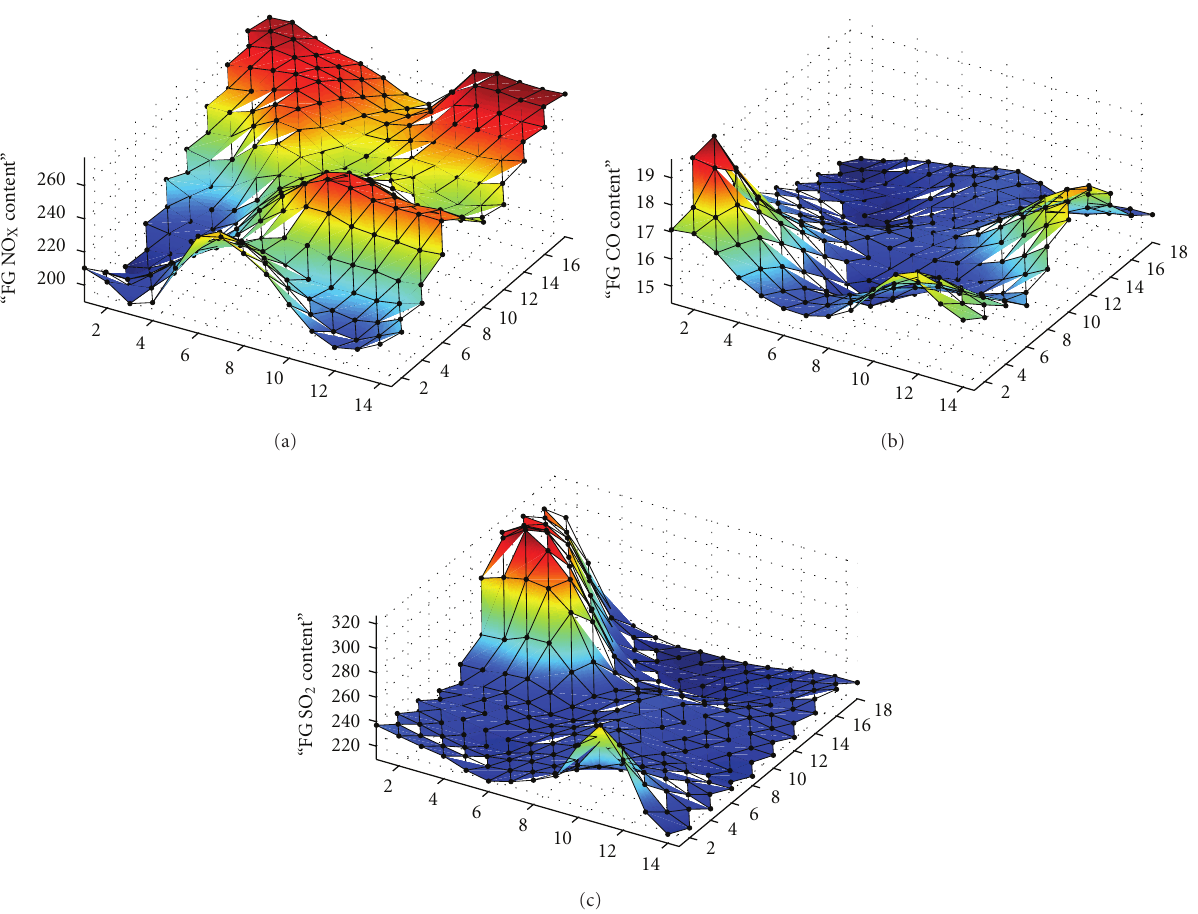
Figure 5: The component planes of di ff erent emission components [mg/Nm 3 ], (a) NO x , (b) CO, and (c) SO 2 , on 18 ∗ 14 SOM grids after modeling the process state of high-steam flow